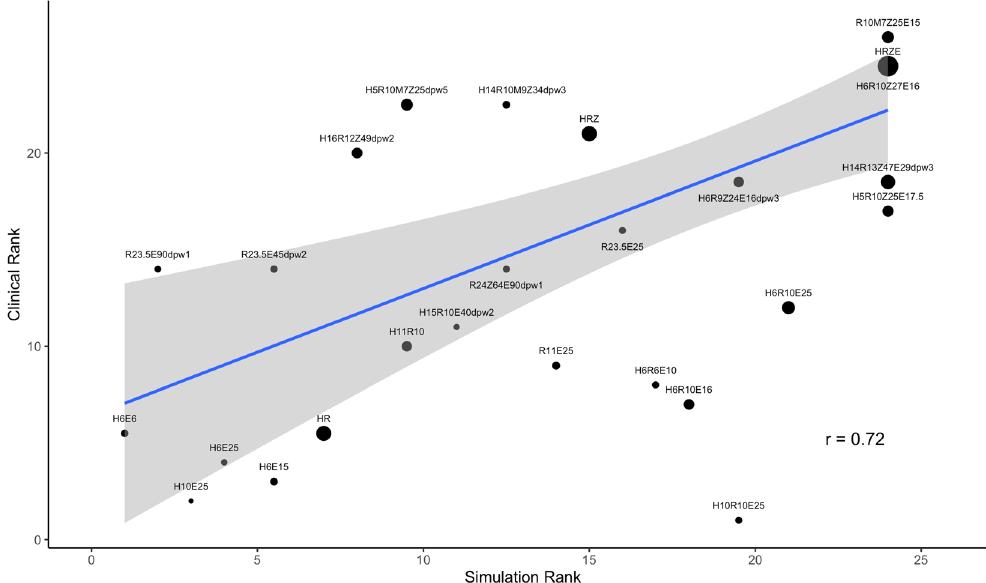
Figure 6. INDIGO-MTB- GranSim compared with clinical data. Comparison and validation of treatment simulations with clinical trial results for 26 different regimens compiled in Bonnet et al. 40 . Predictions from GranSim simulations for 26 drug regimens correlate with clinical outcomes. The simulation rank, ranked by percentage of sterilized granulomas after 8 weeks, and clinical rank, ranked by clinically reported culture conversion, have a weighted correlation of 0.72, weighted by the number of patients treated with each regimen. Plots were made using the ggplot2 package in R 39